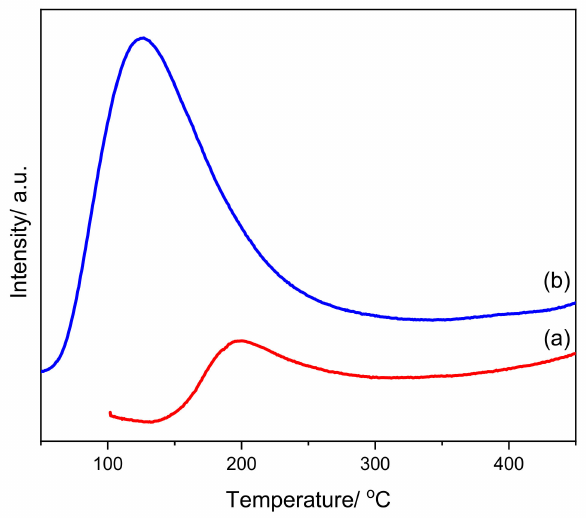
Figure 3. TPD profiles of BCR: ( a ) TPD–NH 3 and ( b ) TPD–CO 2